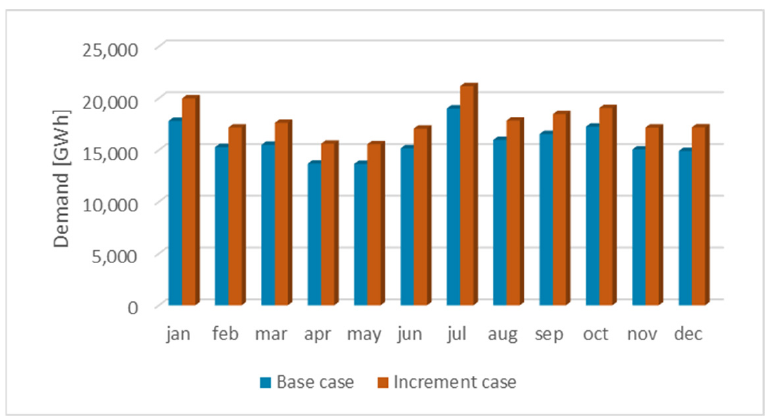
Figure 3. Comparison of the demand at a national level in base case and in increment case. Simulation results show an increase in the average PUN value of about 8.9 € /MWh compared to the base case. In fact, it increases from a value of 52.1 € /MWh (registered in the back-test simulation) to a value of approximately 61 € /MWh. Observing the new PUN duration curve in Figure 4, it can be seen that between the 25th and 75th percentile the average value of the PUN in the assessed scenario (with the increased demand) is between 80 € /MWh and 60 € /MWh (versus the range of 60–40 € /MWh of the base